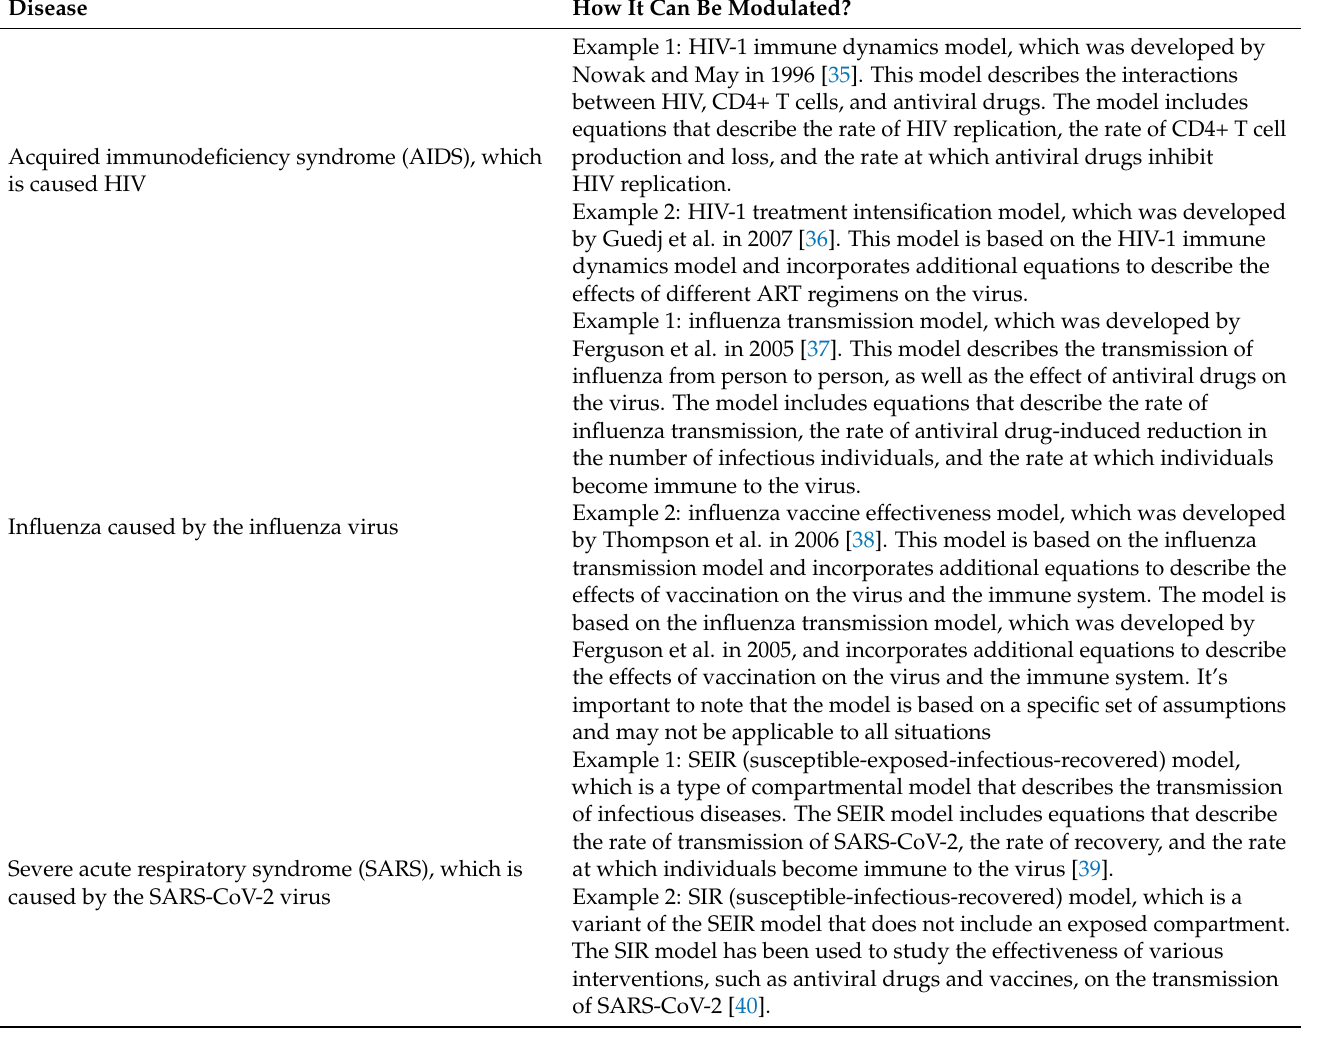
Table 2. Types of the most severe and prevalent diseases caused by virus infections that can be cured by modulating the immune